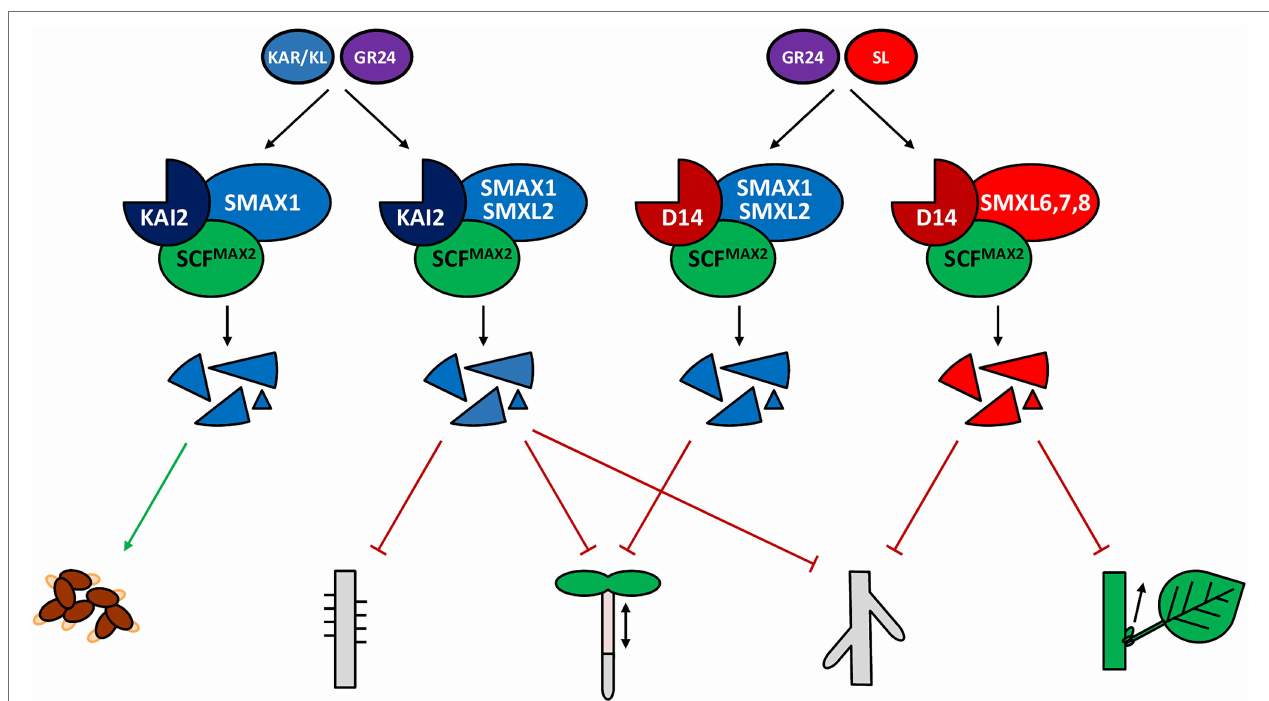
FIGURE 1 | Core D14 and KAI2 signaling pathways. The signaling complexes formed after the perception of their respective ligands as well as a selection of phenotypes affected by the SMXL protein degradation are shown, induction of seed germination induction, inhibition of root hair development, hypocotyl elongation, lateral root formation, and shoot branching. A more extensive list of processes regulated by these pathways can be found in Table 1 . GR24, rac -GR24; KL, KAI2 ligand; SL,